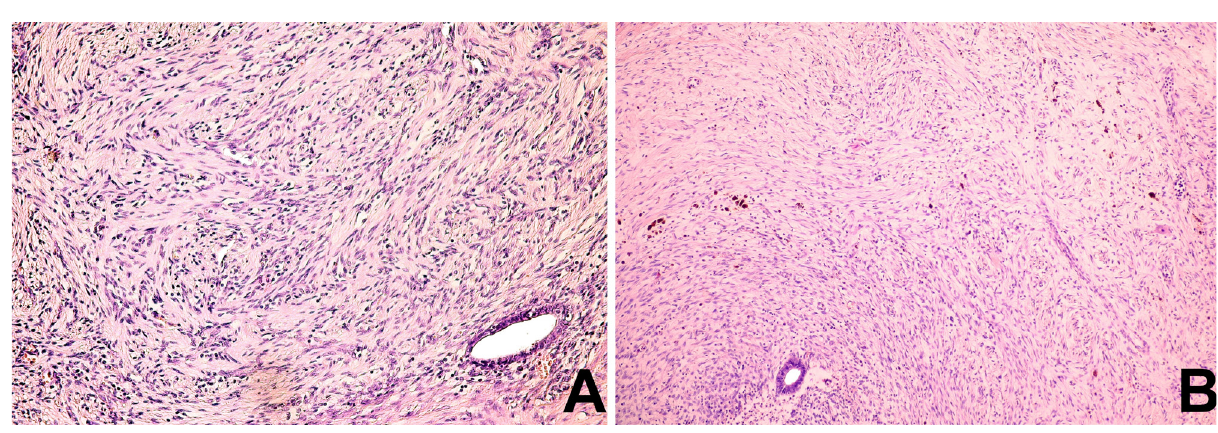
Fig. 3. Endometriotic neuropathy. A: Intraneural spread of endometriotic gland (visible in the lower right corner) with marked neural hypertrophy and hyperplasia (hematoxylin-eosin staining, original magnification ×100). B: Involvement of the parasympathetic ganglion of the autonomic nervous system by endometriosis. Numerous bundles of nerve fibers, cell body of the postsynaptic neuron (visible in the right half of the field) and deposits of haemosiderin are noted (hema- toxylin-eosin staining, original magnification